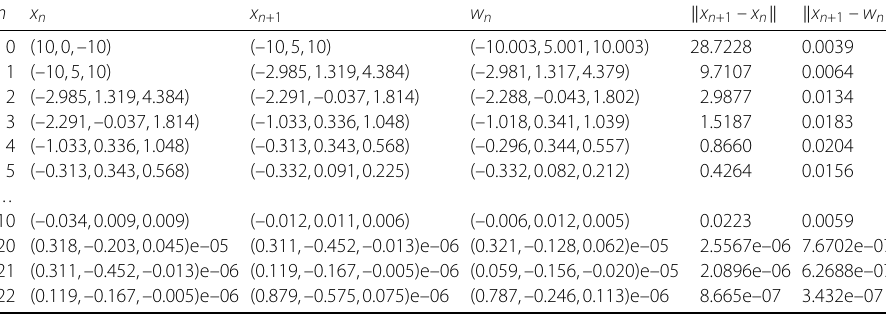
Table 2 Convergence of the sequence in Algorithm